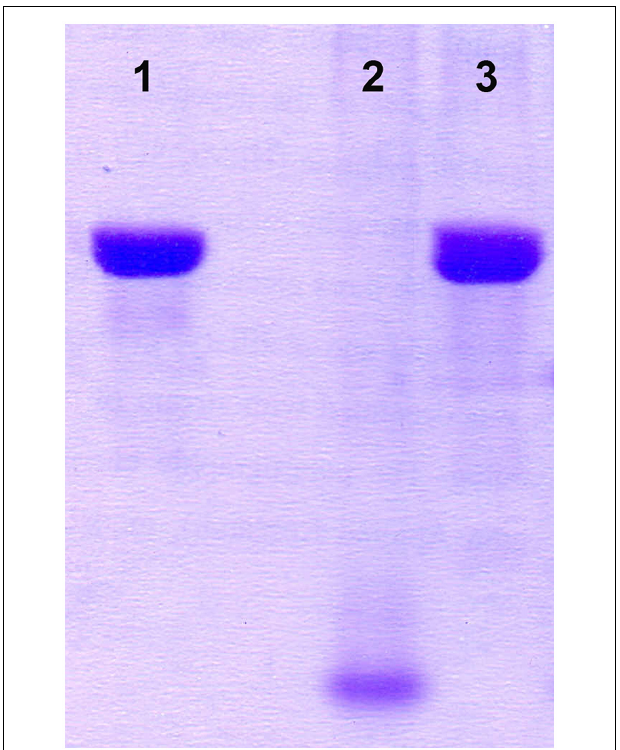
FIGURE 1 |Analysis of proteinase inactivity of BGMN1-501/pG + host9prtP integrant. (1) β -casein, (2) BGMN1-501, (3) prtP integrant.